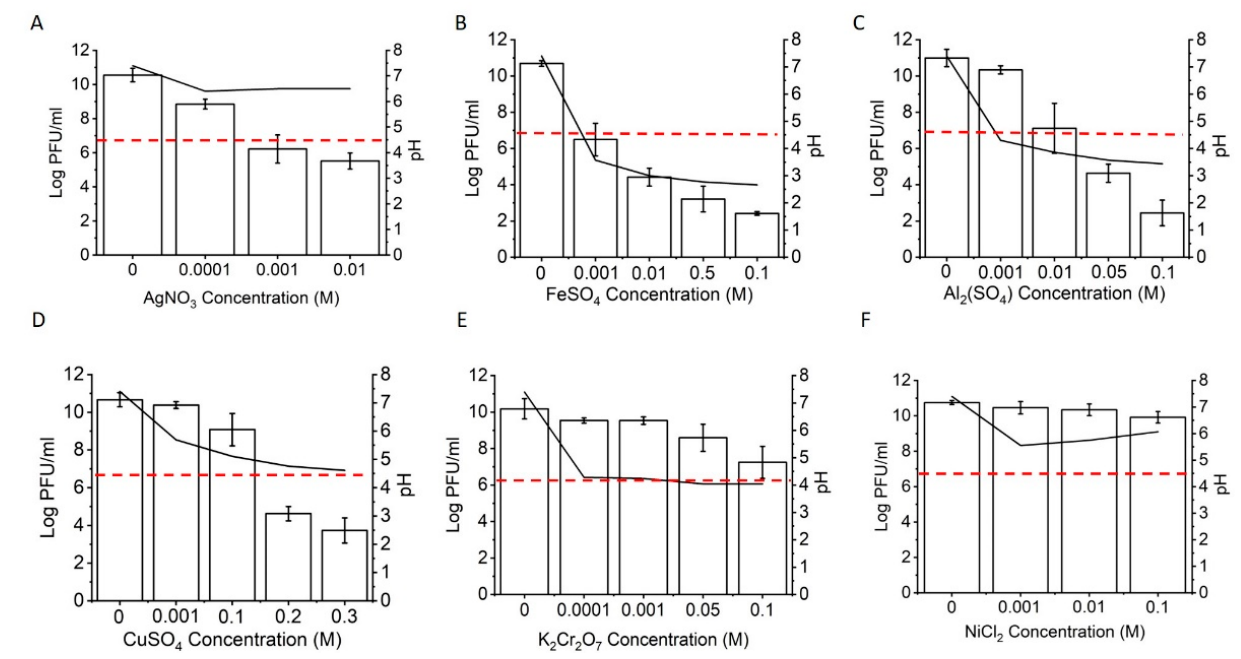
Figure 2. Phi6 viral titer after treatment with metal solutions. ( A ) Phi6 treated with silver nitrate; ( B ) ferrous sulphate; ( C ) aluminum sulphate; ( D ) potassium dichromate; ( E ) copper sulphate; ( F ) nickel chloride. On the left y-axis, PFU/mL, and on the right y-axis, pH of the solutions are presented. The black lines represent the pH of the solutions, the red dashed lines indicate the decrease in viral titer by 99.99% compared to the control. The average values and standard deviations are shown (n ≥ 3).